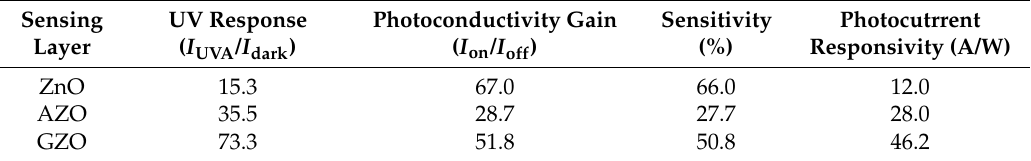
Table 2. Summary of the photosensing and photoswitching characteristics, and photoresponsivity of ZnO-based MSM